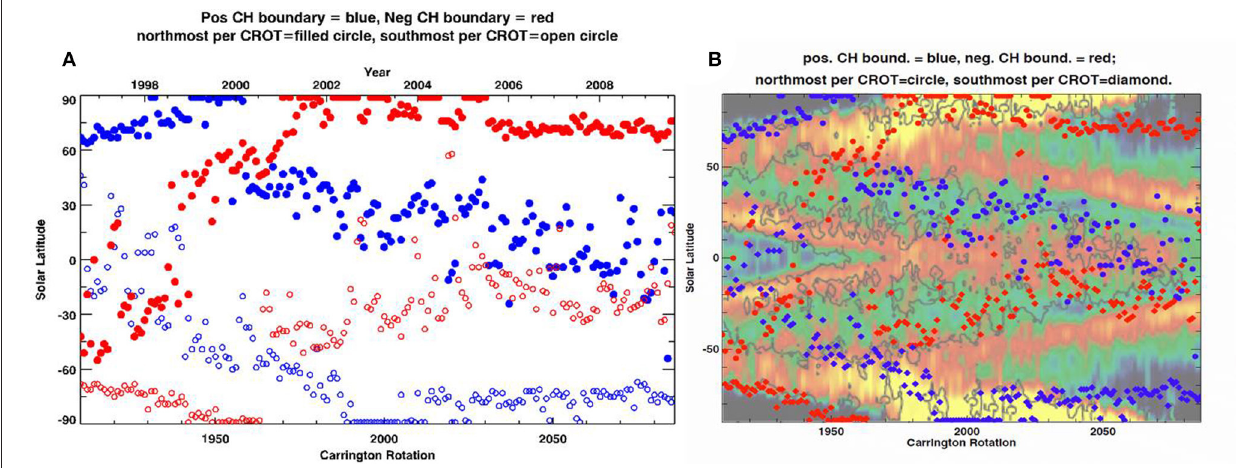
FIGURE 6 | (A) The poleward-most CH boundaries per CR for SC 23. Closed (open) circles indicate the most northward (southward) extensions of CH boundaries for each CR. Red and blue indicate magnetic polarity. (B) This same plot overlaid on a plot of the zonal flows (torsional oscillations) of the near-surface (0.99 R ⊙ ) magnetic field from GONG, MDI, and HMI data, covering the period from the beginning of the GONG observations in 1995 to the present (from Howe, 2016; prepared by R. Komm).